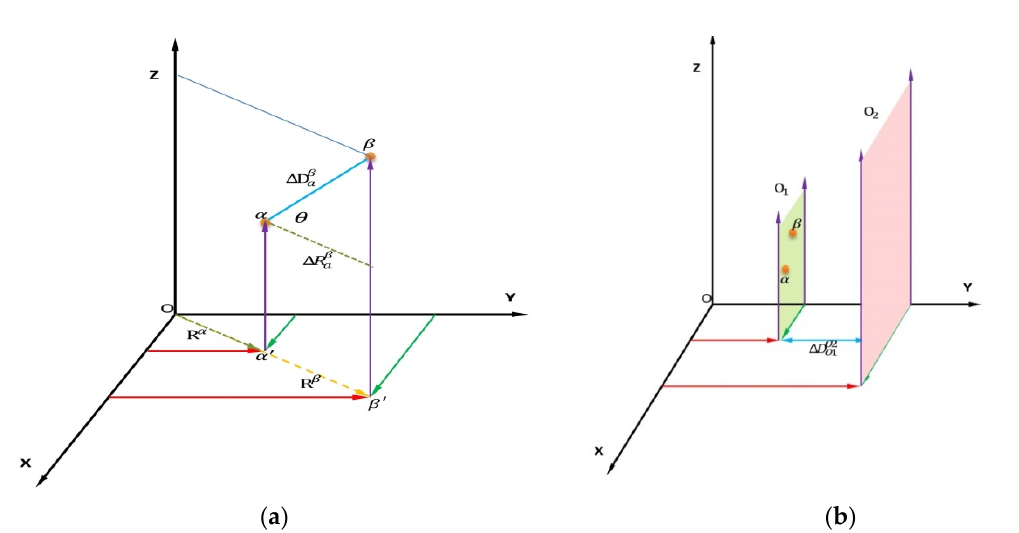
Figure 4. The points’ relationship in a slice and between objects. ( a ) The points’ relationship in a slice. ( b ) The points’ relationship between